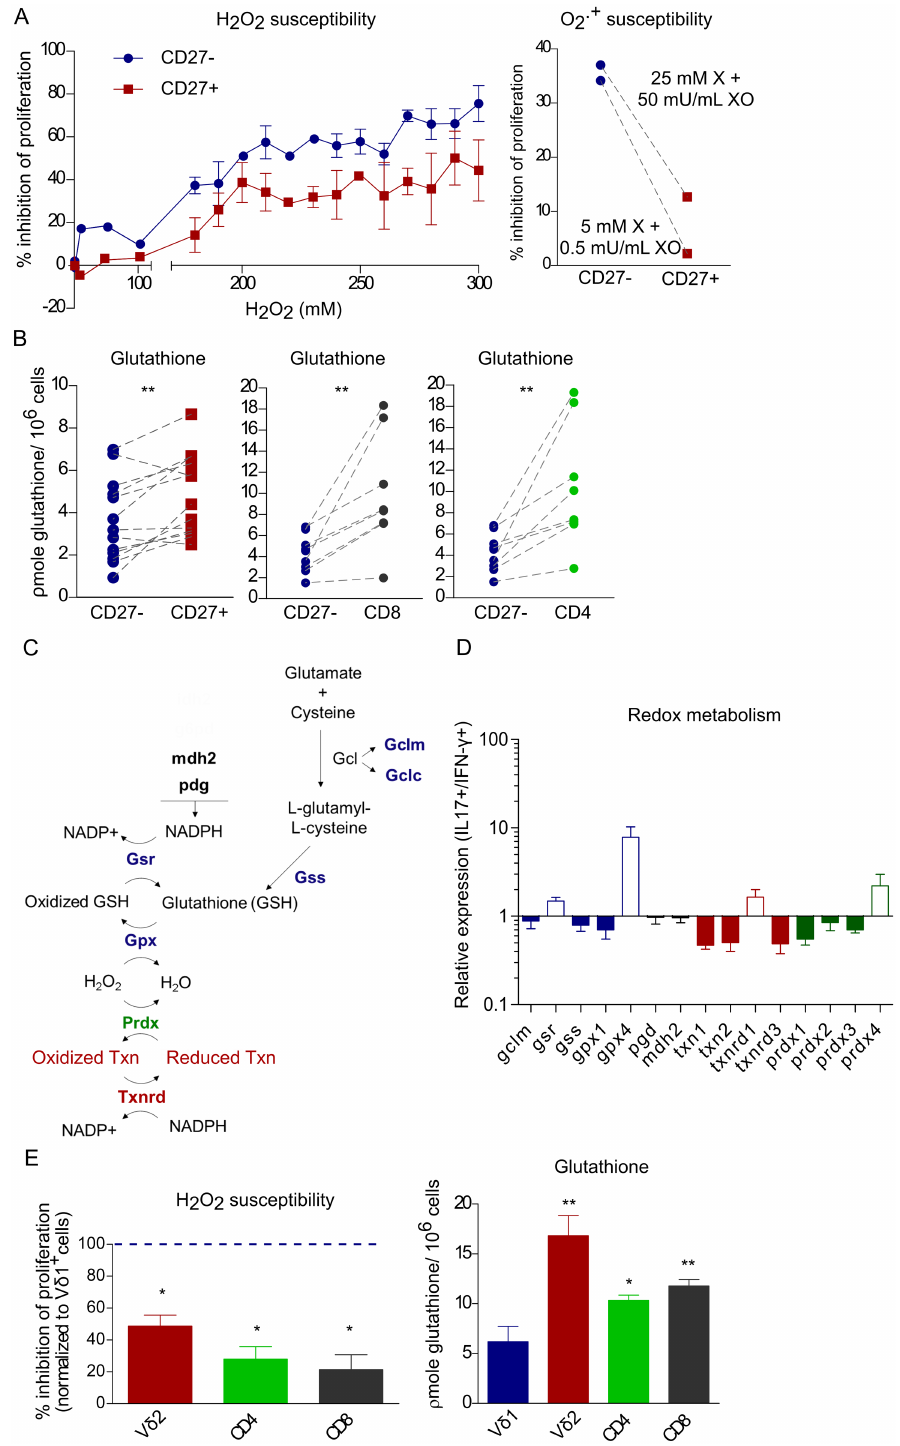
Fig 4. Murine CD27 − γδ T cells and human V δ 1 + γδ T cells express low levels of glutathione and are highly susceptible to ROS. (A) FACS-sorted CD27 − and CD27 + γδ T cells were stimulated and proliferation was assessed by CTV dilution, with increasing concentrations of H 2 O 2 (left, n = 2–3) or with different concentrations of the superoxide-generating system X/XO, right. (B) Total glutathione levels in CD27 − γδ , CD27 + γδ , CD8 + , and CD4 + T cells sorted from spleen and lymph nodes of tumor-free mice. Dotted lines link subsets from the same mouse.